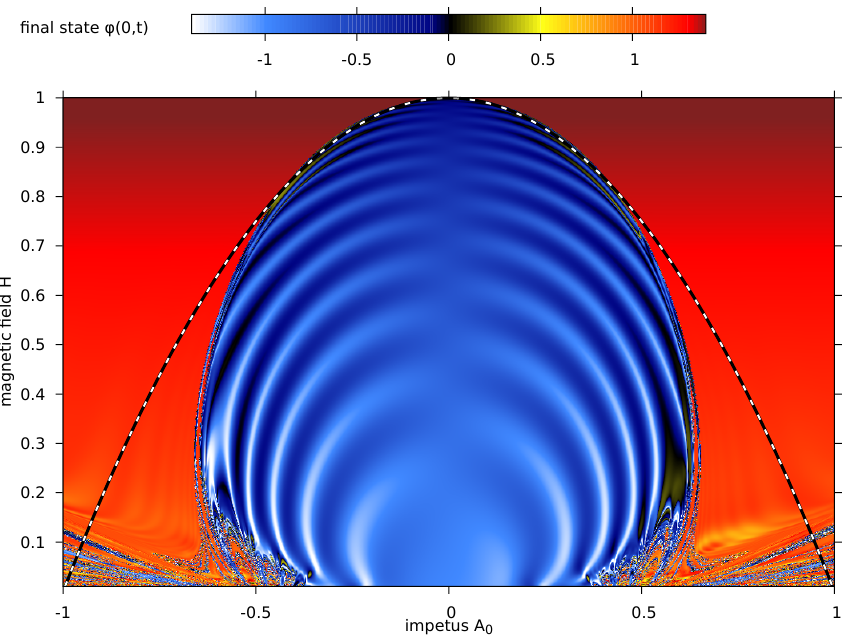
Figure 17 . The (cid:12)eld value on the boundary at time t f = 50 for initial conditions (cid:30) ( x; 0) = (cid:30) B ( x ), (cid:30) t ( x; 0) = A 0 ! B (cid:17) B ( x ). The blue colour represents the region without kink creation. The dashed line corresponds to the function H = 1 (cid:0) A 2 .